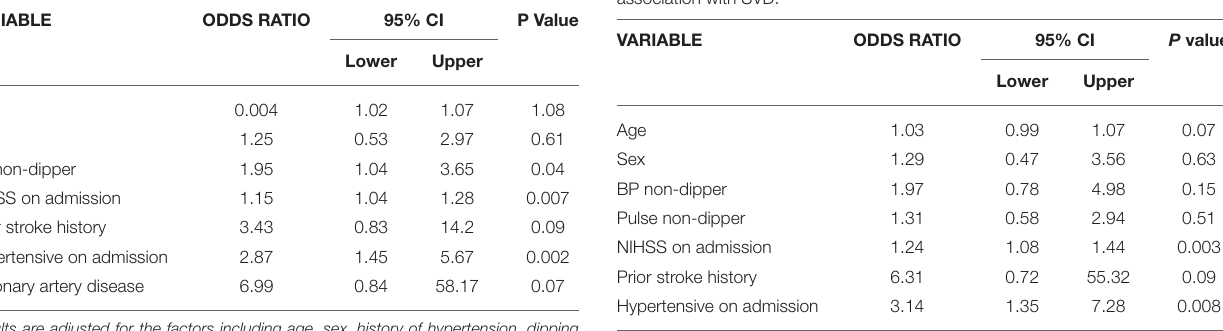
TABLE 5 | Multivariate analysis after adding pulse non-dipping status to see the association with